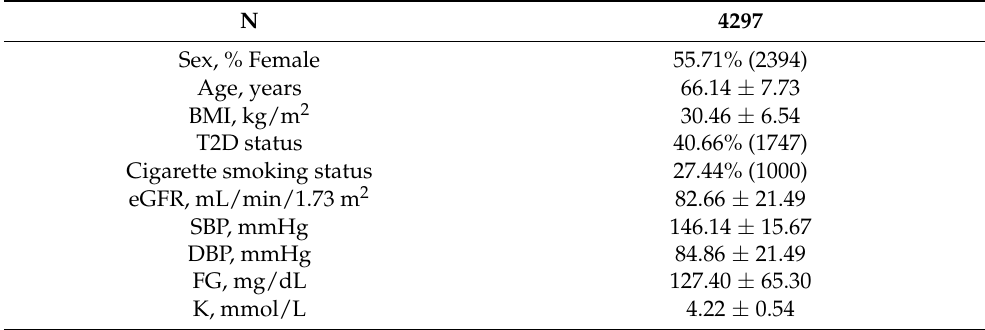
Table 1. Baseline GenHAT chlorthalidone participant demographics 1 .